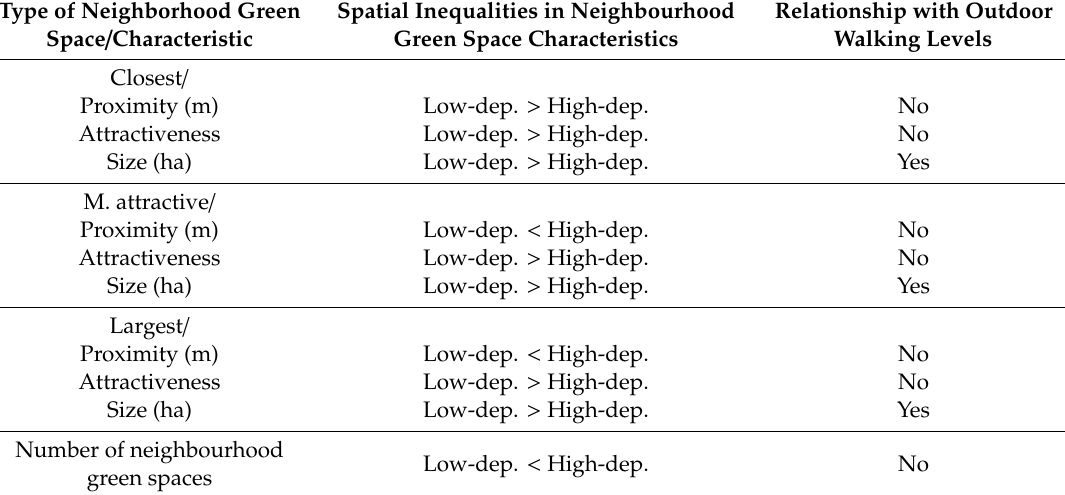
Table 8. Combination of results on spatial inequalities in neighbourhood green spaces characteristics and relationships between neighbourhood green spaces characteristics and outdoor walking